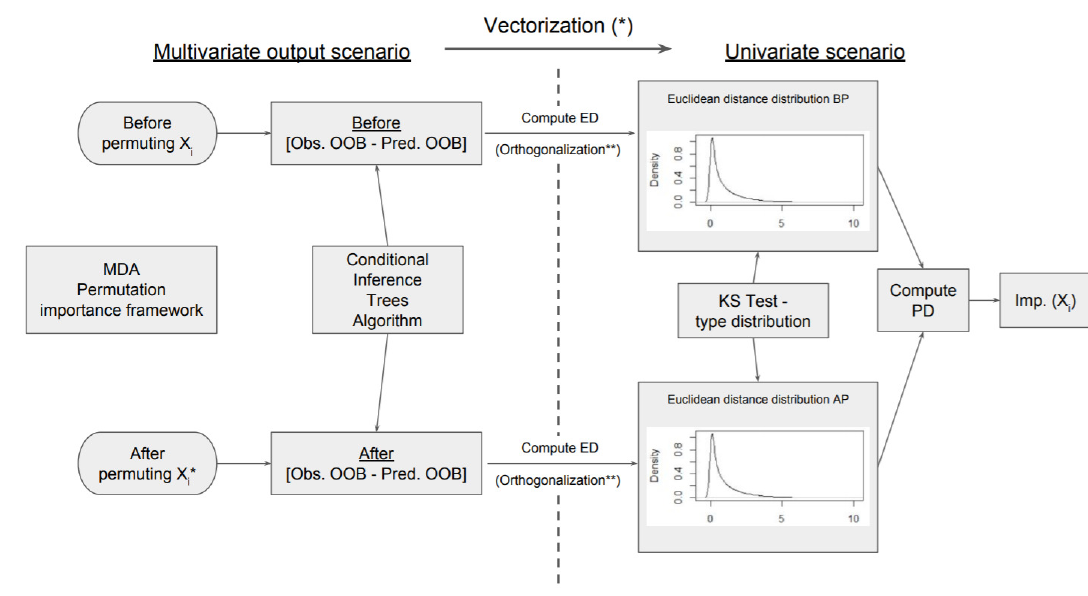
Figure 3. Variable importance analysis (VIA) framework.